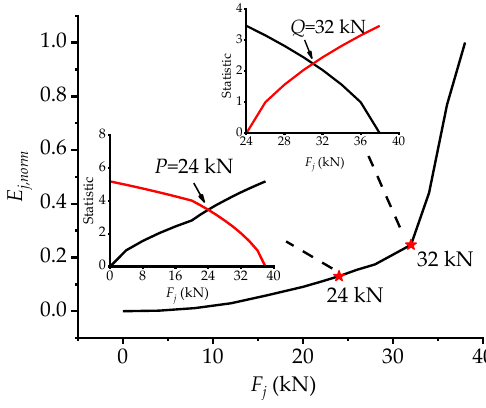
6 of 16 Figure 4. Loads were firstly imposed wi Figure 4. Experimental bridge model and loading apparatus. 4. Analysis of the Bridge Model’s Stressing State Characteristics and its Parameters 4.1. GSED-Based Stressing State Mode and Characteristic Parameter Structural stressing state characteristics of the bridge model can be properly manifested by stressing state mode,